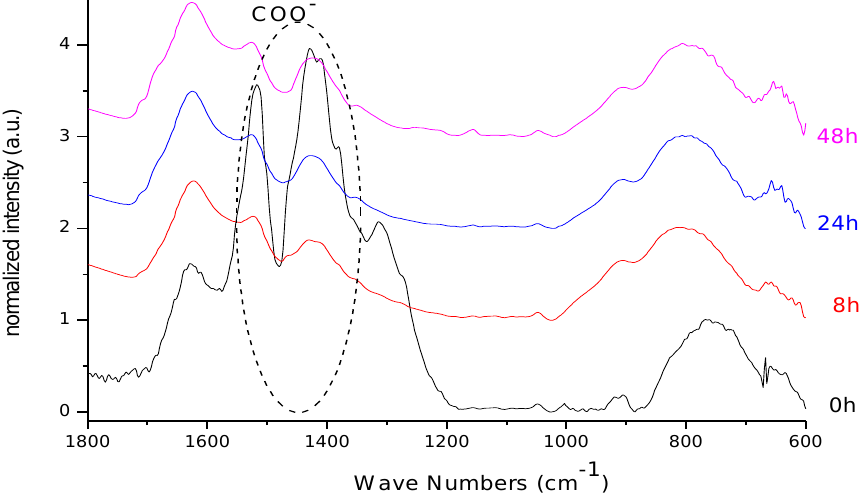
Figure 17. FT-IR spectra (KBr: 2 mg sample, 150 mg KBr) of DDA@TiO times of